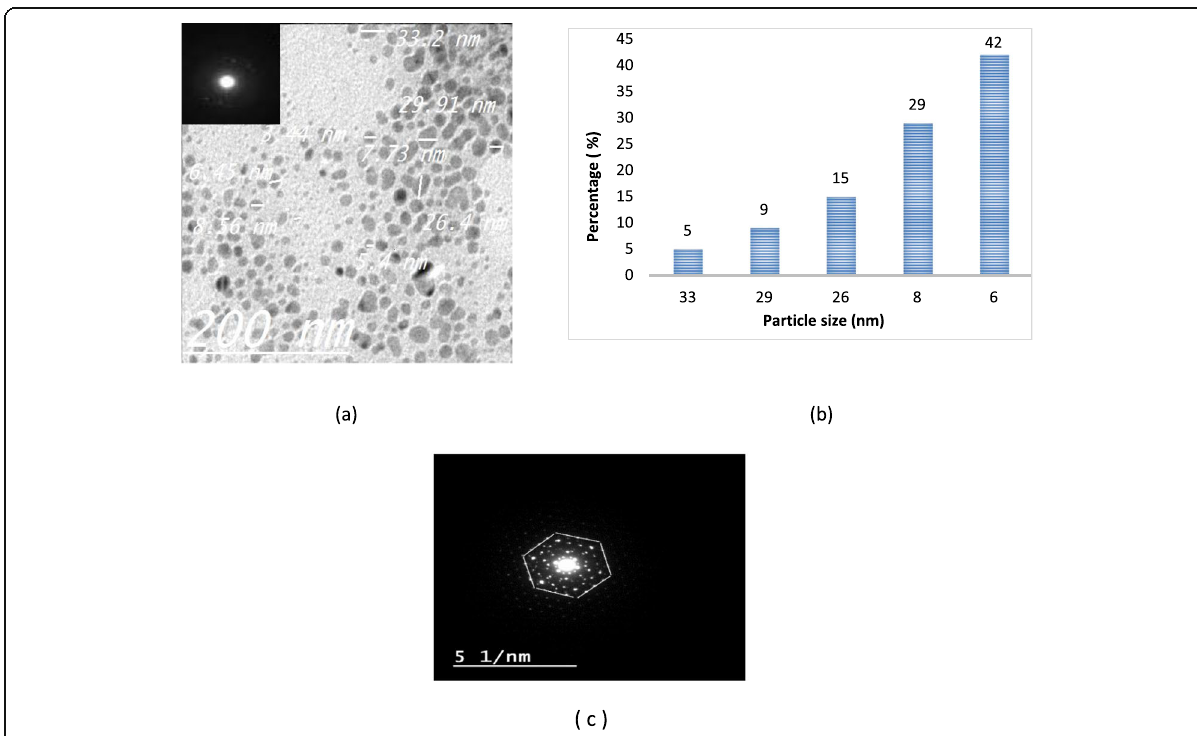
Fig. 10 a TEM analysis, b histogram, and c photo SAED of graphetized bentonite